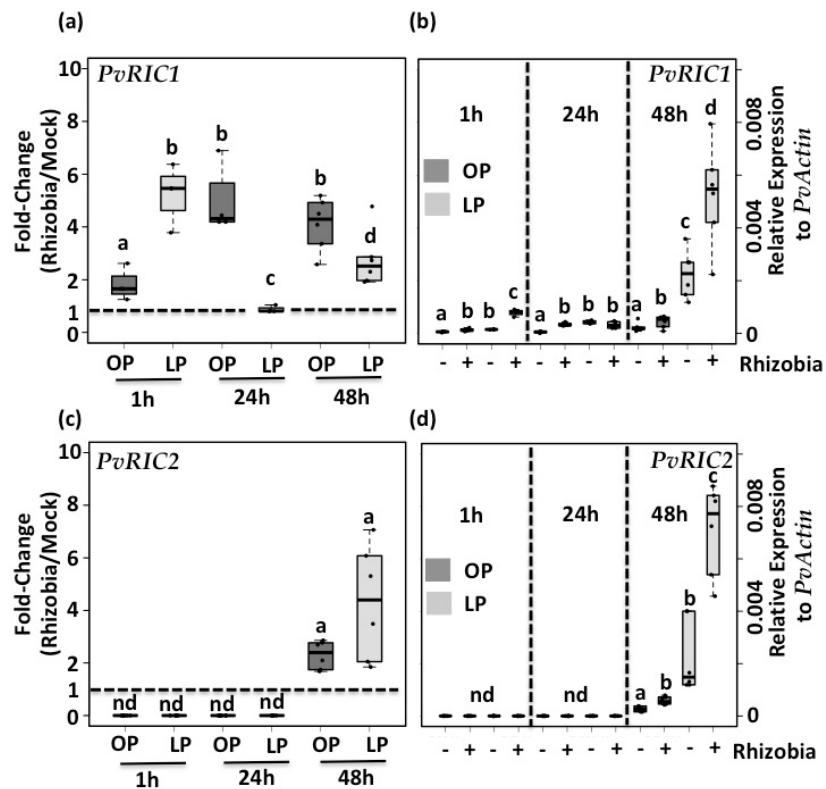
Figure 4. Pi deficiency increases the expression of PvRIC1 and PvRIC2 even in the absence of rhizobia. Rhizobia-triggered expression of PvRIC1 ( a ), and PvRIC2 ( c ) genes in common bean seedlings growing under OP or LP conditions and inoculated with mock or rhizobia. Data showed are the fold-changes (e.g., OPR/OPM) obtained from four independent replicates, each one containing susceptible zones from four different plants. Dashed line shows basal expression (e.g., no induction triggered by rhizobia). Expression levels of PvRIC1 ( b ) and PvRIC2 ( d ) at various times (1, 24 and 48 h) post inoculation with mock ( − ) or rhizobia (+) in common bean seedlings growing under OP (dark-gray) or LP (light-gray) conditions. Despite several attempts, we were not able to detect reproducible and consistent expression (non-detected: ND) of PvRIC2 at one and 24 h post-inoculation with mock or rhizobia. Data showed was obtained from four independent replicates, each one containing susceptible zones from four different plants. Box plots represent first and third quartile (horizontal box side), minimum and maximum (outside whiskers). One-way ANOVA, followed by a Tukey HSD test was performed ( p -value < 0.01). Statistical classes sharing a letter are not significantly different.